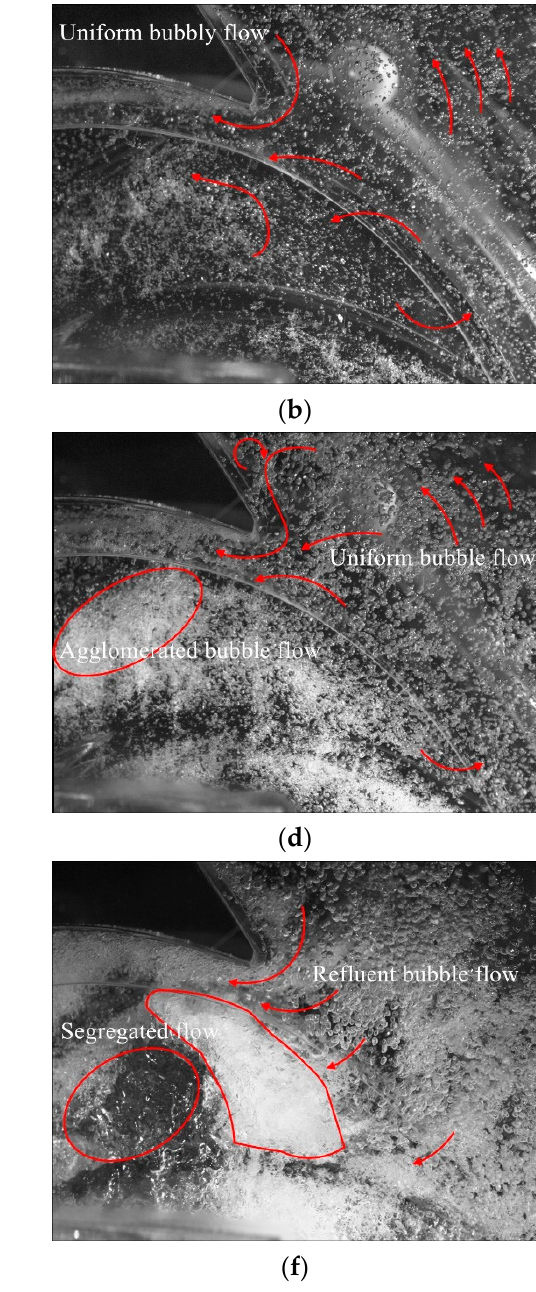
Figure 10. Flow pattern under φ = 0.04 for different α i : ( a ) 0.7%; ( b ) 1%; ( c ) 2%; ( d ) 2.5%; ( e ) 3%; and ( f ) 3.5%, pump shut off condition.